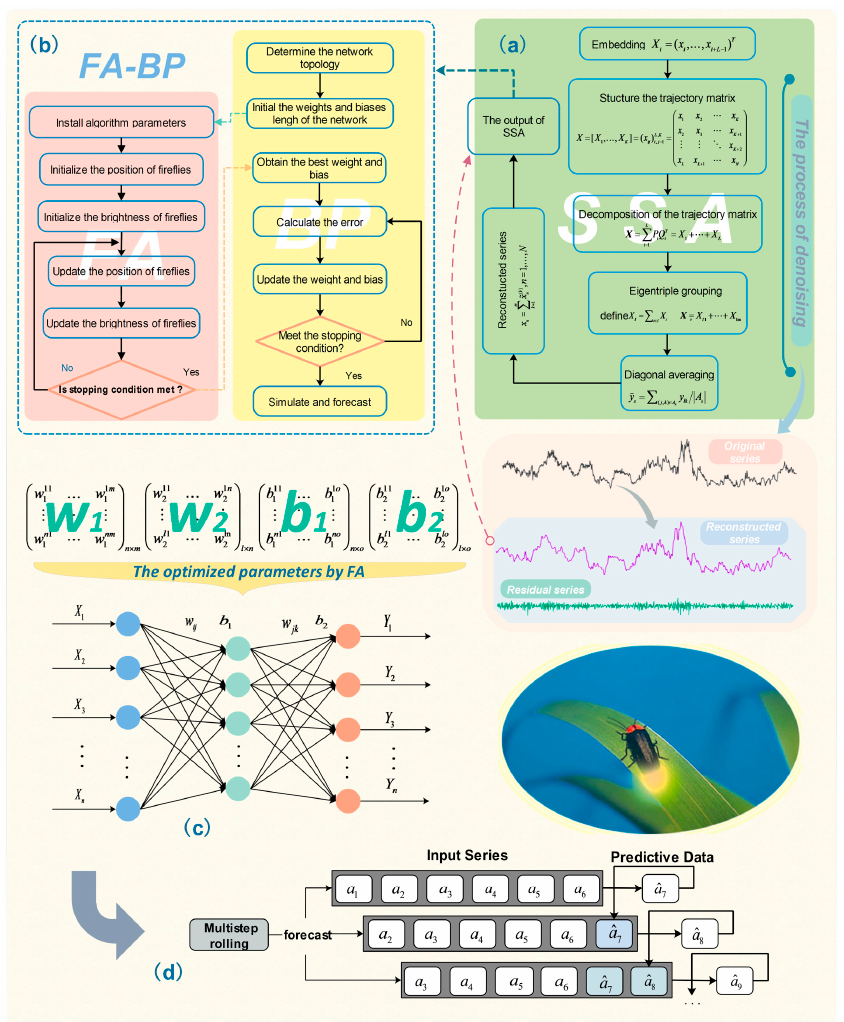
Figure 2. The structure of the proposed SSA ‐ FA ‐ BP, ( a ) The structure of SSA; ( b ) The structure of FA ‐ BP; ( c ) The schematic of back ‐ propagation neural network; ( d ) The mechanism of multistep rolling forecasting. of FA-BP; ( c ) The schematic of back-propagation neural network; ( d ) The mechanism of multistep rolling